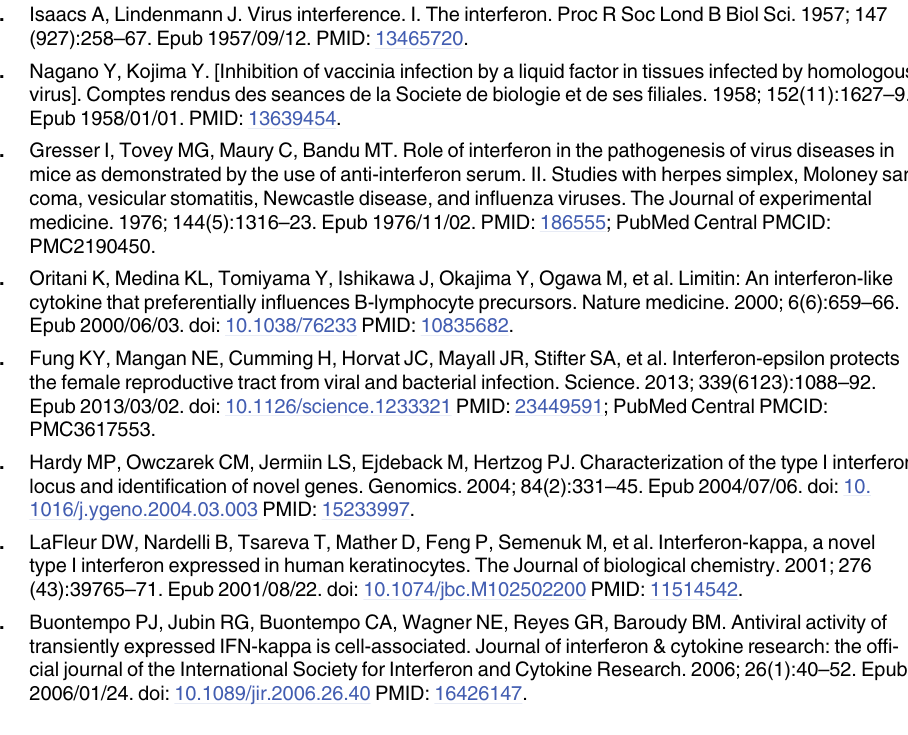
S1 Table. ELISA Binding Specificity of Type I IFN Antibodies. Binding of mAbs to adsorbed recombinant IFNs was measured by